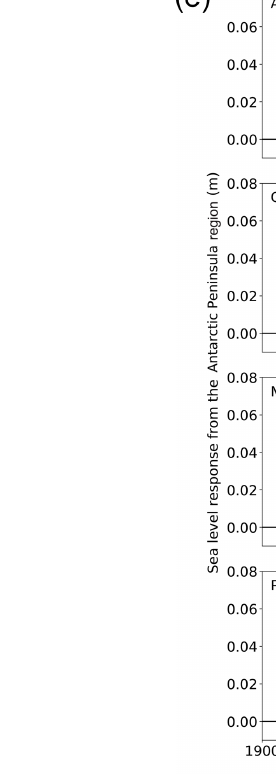
Figure 10. (a) Projection of East Antarctica’s sea level contribution under the RCP8.5 carbon concentration scenario following the procedure depicted in Fig. 1 and detailed in Sect. 2. The white line represents the median value, the dark shading the likely range (66th percentile around the median), and the light shading the very likely range (90th percentile around the median). (b) Projection of the Ross sector’s sea level contribution under the RCP8.5 carbon concentration scenario as in panel (a) . (c) Projection of the Amundsen sector’s sea level contribution under the RCP8.5 carbon concentration scenario as in panel (a) . (d) Projection of the Weddell sector’s sea level contribution under the RCP8.5 carbon concentration scenario as in panel (a) . (e) Projection of the Antarctic Peninsula’s sea level contribution under the RCP8.5 carbon concentration scenario as in panel (a)